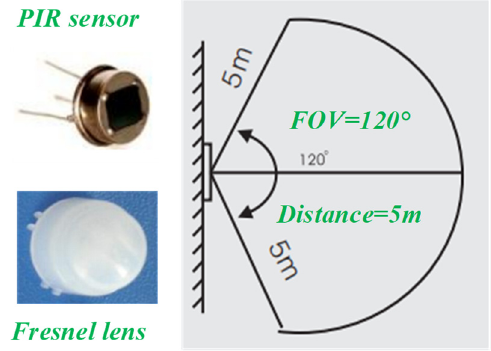
Figure 3. Key parameters of the Fresnel lens and PIR sensor.